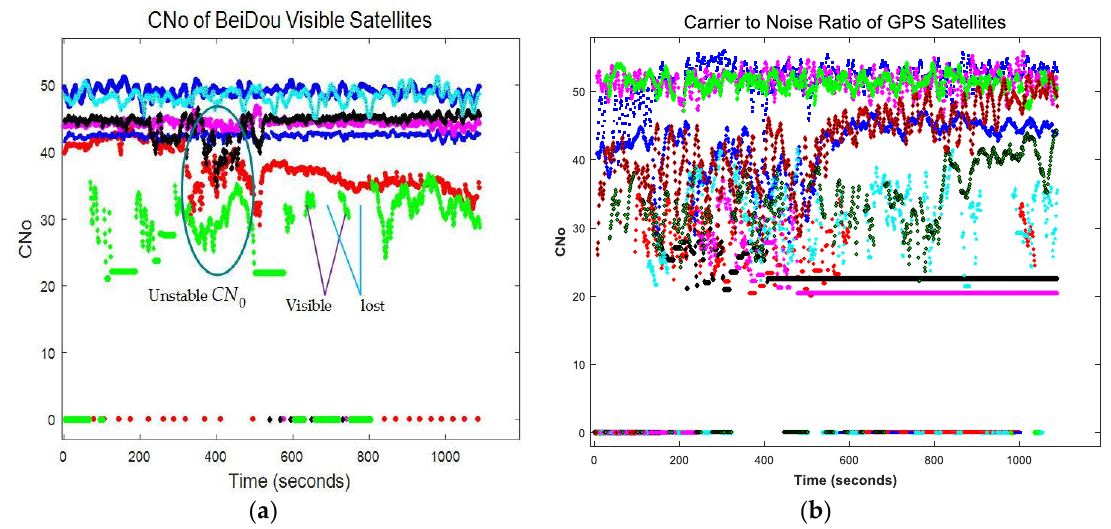
Figure 8. Carrier-to-noise ratio of visible satellites ( a ) BeiDou ( b ) GPS.